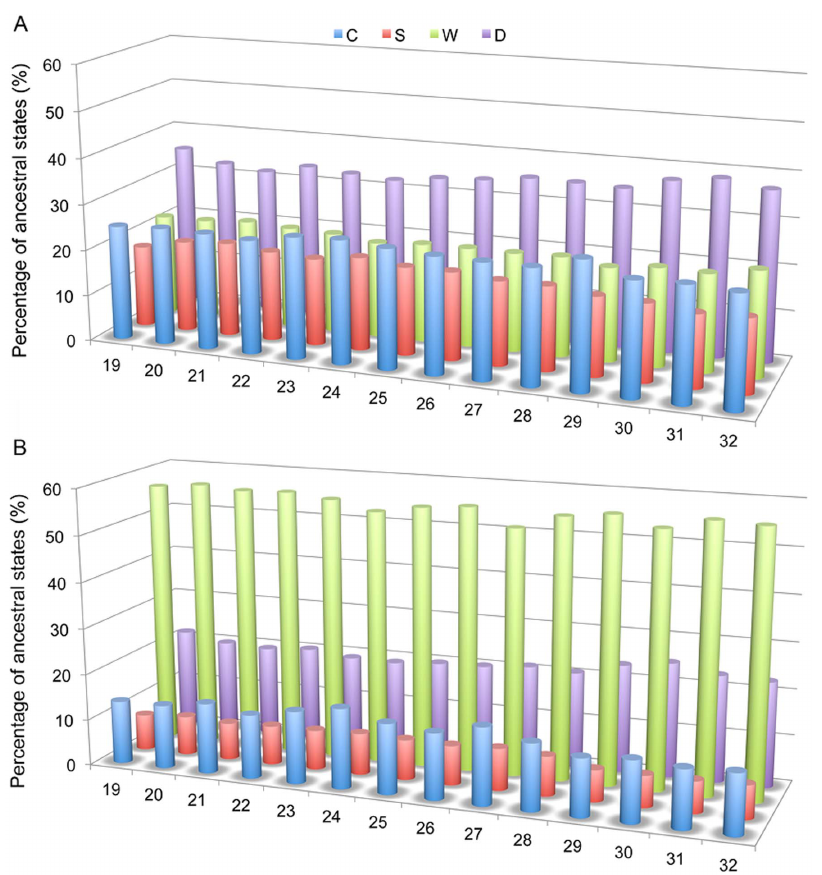
Figure 4. Fate of the gene pairs in pan-Overlaps over the internal nodes of the phylogeny of the studied genomes (see Fig. 3 for node numbering). (A) Average of the percentages of the gene pairs inside operons over the internal nodes of the phylogeny. (B) Average of the percentages of the gene pairs outside of operons over the internal nodes of the phylogeny.